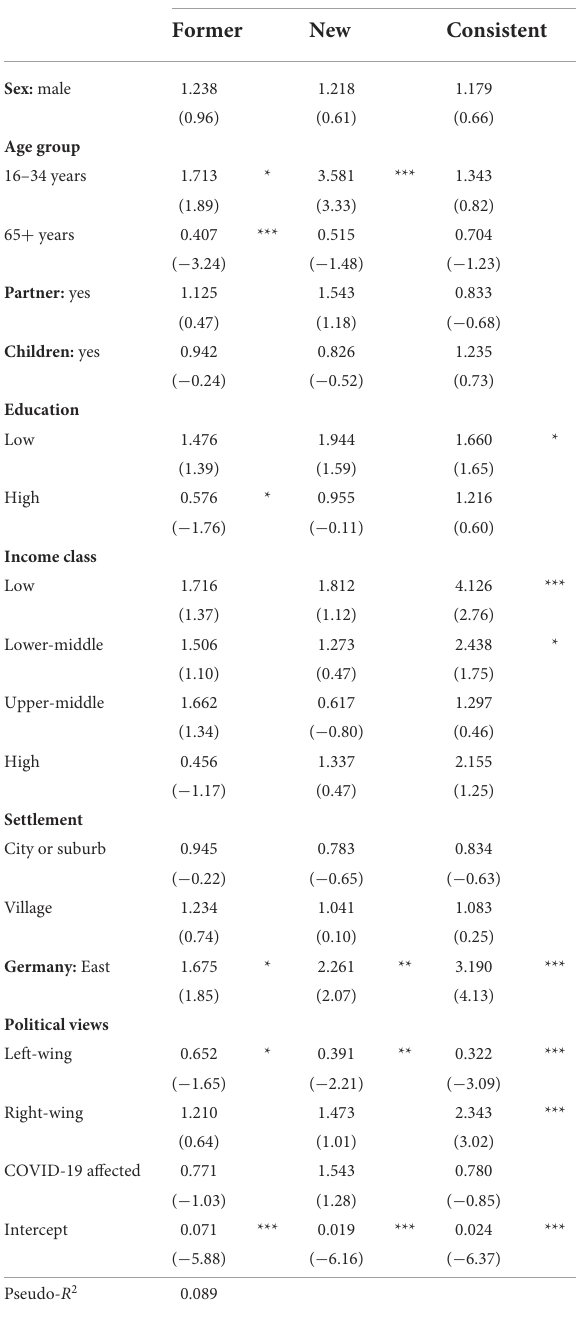
The table shows the results from a multinomial logistic regression of type of Corona deniers on socio-political characteristics ( N = 1,280). The presented coefficients are relative risk ratios (in comparison to the consistent realists) with z -scores in brackets. Significance of the estimates in two-sided tests: * p